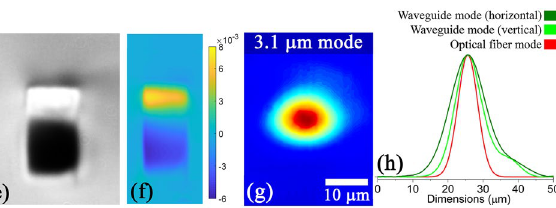
Figure 6. ( a ) DIC microscope image, ( b ) Refractive index profile ( c ) 3.1 μm mode and ( d ) its vertical and horizontal line profiles of a 12 μm wide waveguide (0.6 μm pitch) written at a repetition rate of 5 kHz and 700 nJ pulse energy in the 45HfF 4 –10ZrF 4 glass.